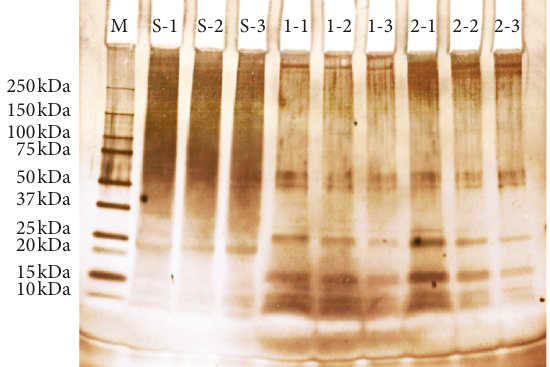
Figure 5: SDS-PAGE of the regenerated silk fibroin and its en- zymatic hydrolysates obtained using FoodPro in the 1st step and Flavourzyme in the 2nd step. M: molecular weight marker. S-1: regenerated silk fibroin, 84 μ g/well. S-2: regenerated silk fibroin,